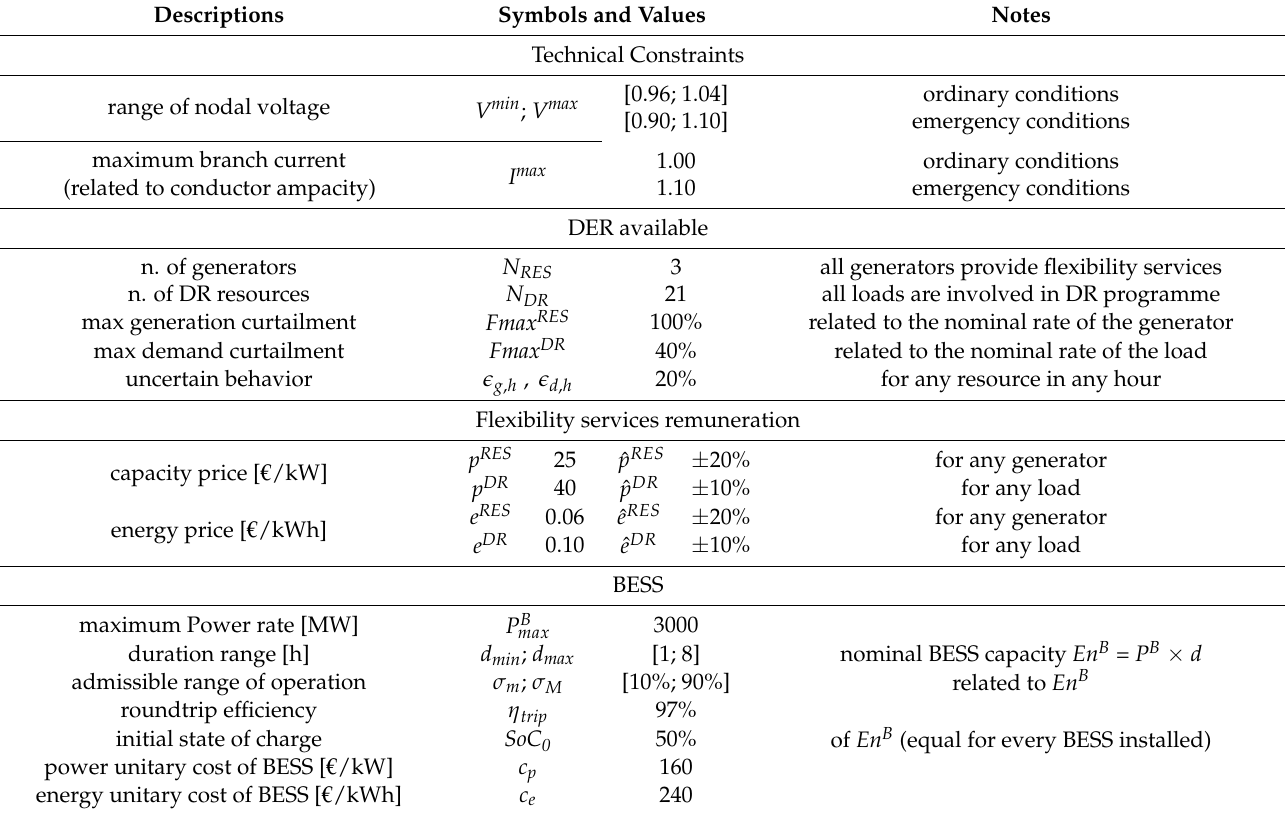
Table 4. Main data adopted for the